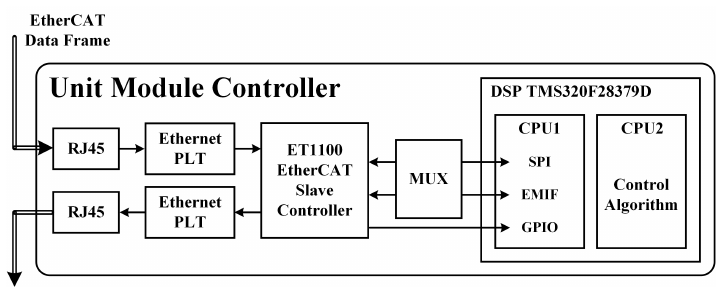
Figure 7. The structure of the unit module